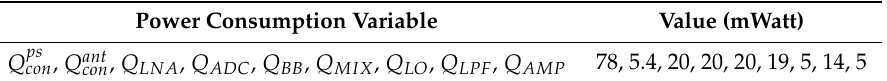
Table 1. Power Consumption values for the proposed scheme.